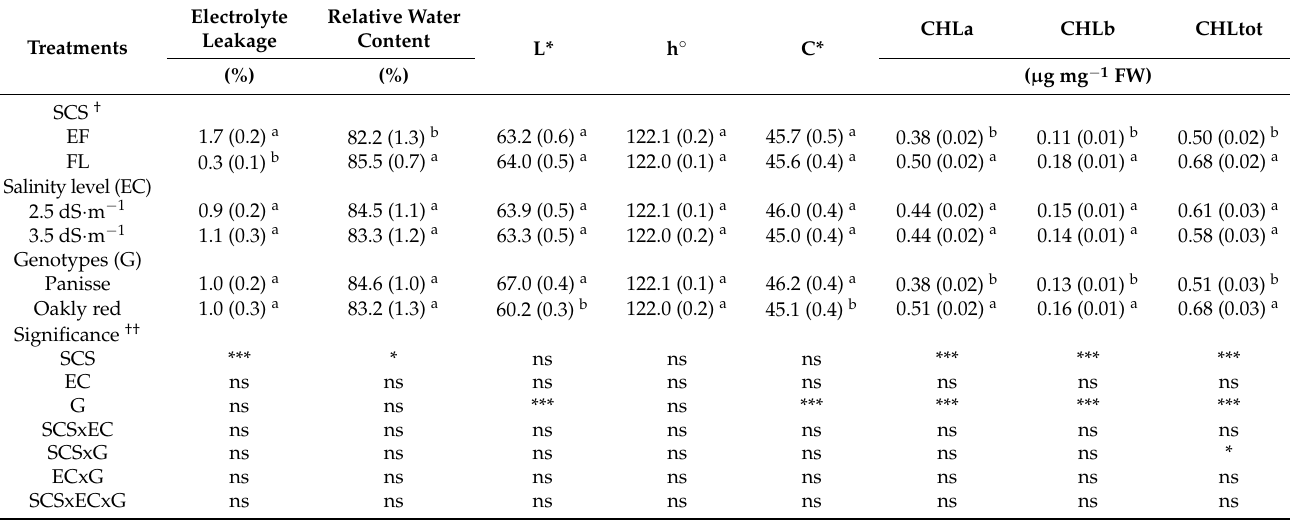
Table 2. Effect of soilless cultivation system (SCS), salinity level (EC) of nutrient solution, and genotype (G) on the bio-physiological traits of oak-leaf lettuce (autumn